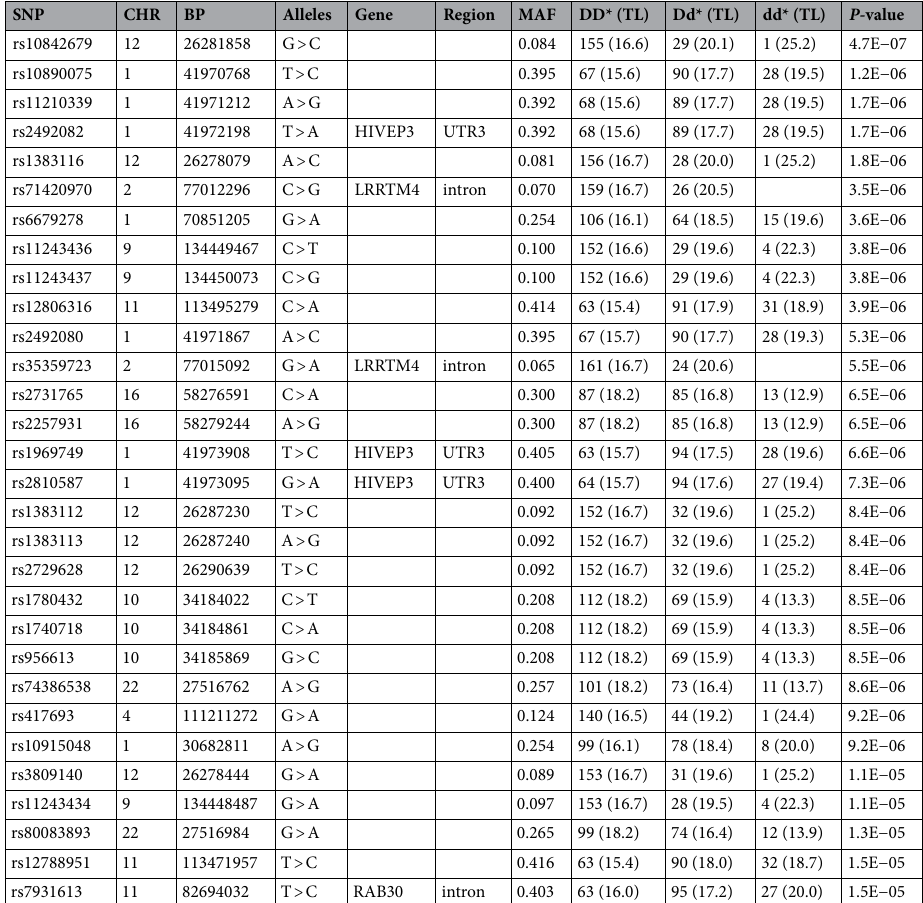
Table 3. Single nucleotide polymorphisms associated with germline telomere length in neuroblastoma patients. Abbreviation: CHR (chromosome), BP (base pair), TL (telomere length), D (dominant allele), d (recessive allele), *DD, Dd, dd means GG, GC, CC genotypes in rs10842679 (Alleles: G >